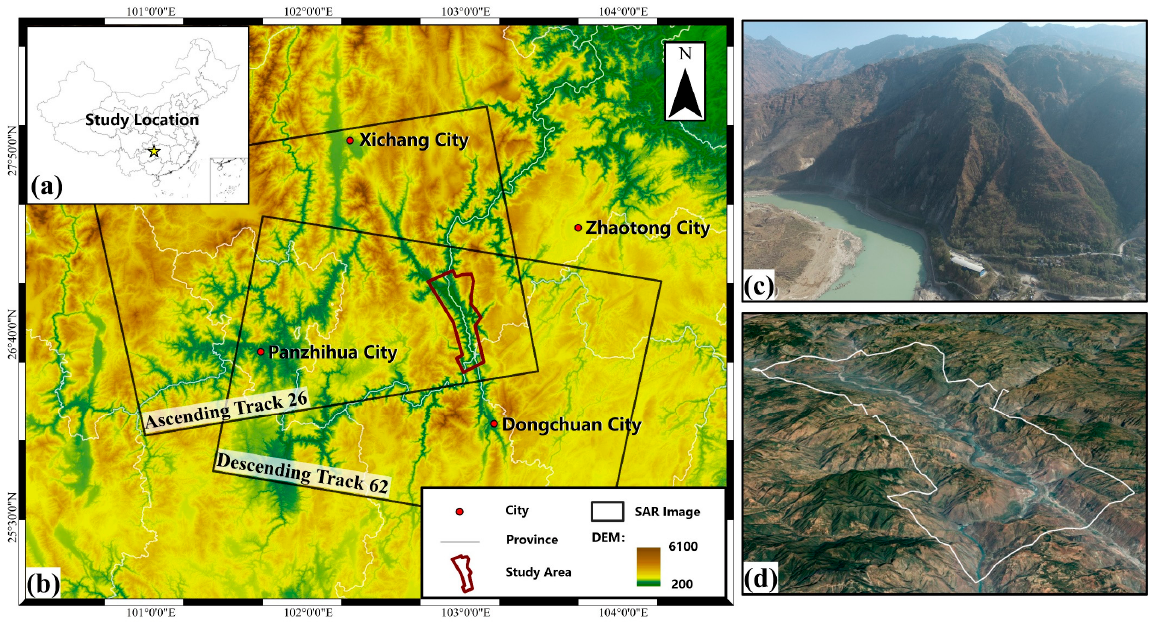
Figure 1. ( a ) Topographic map of the study area; ( b ) location of the study area; ( c , d ) images of the study area from Google Earth.